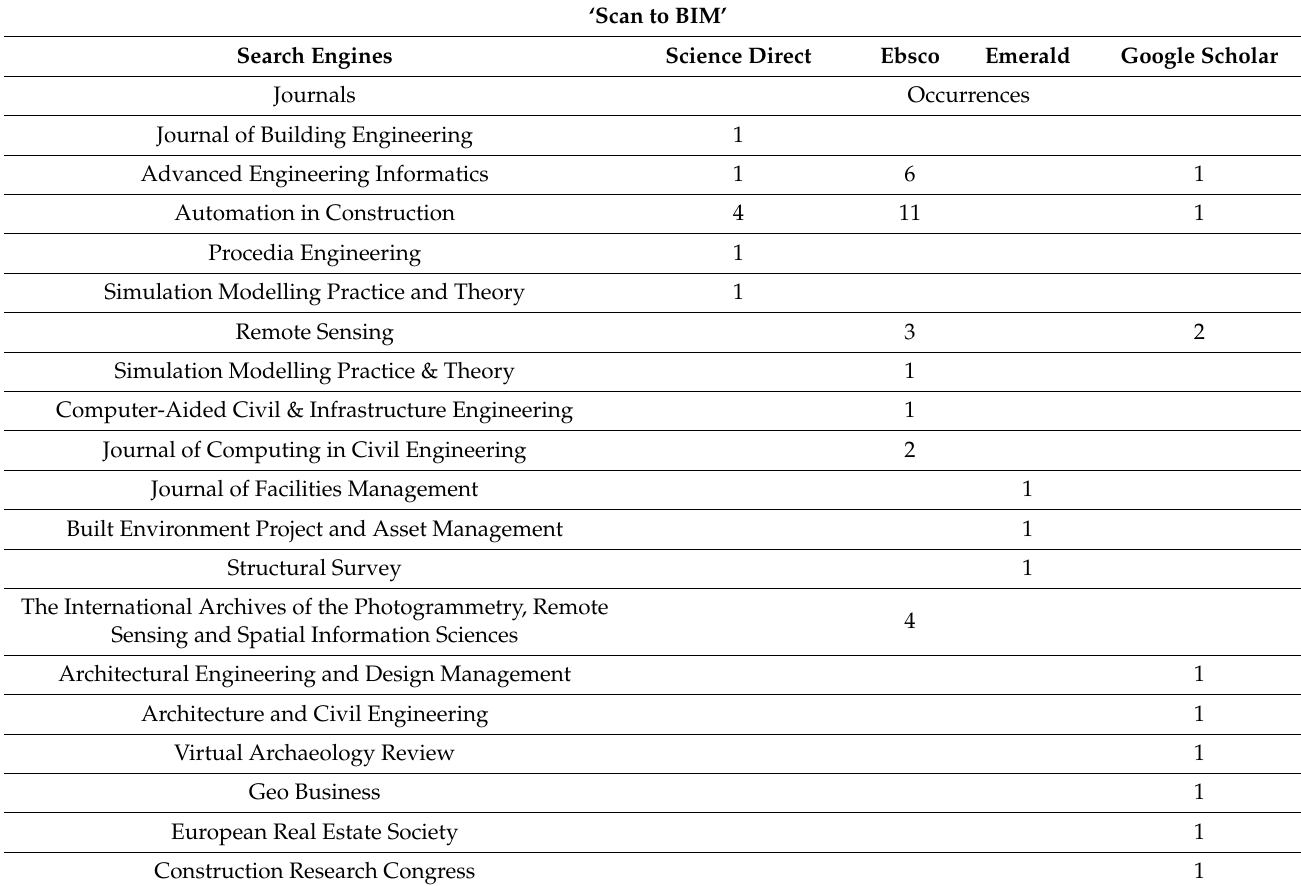
Table 2. “Scan to Building Information Modeling (BIM)” Results.